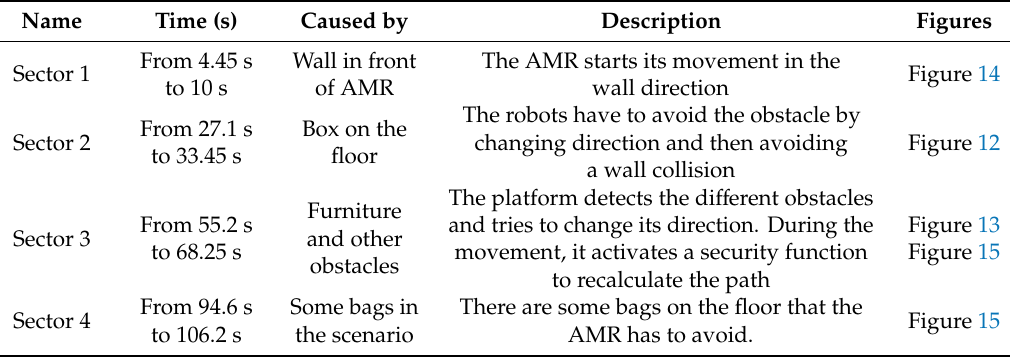
Table 2. Mobile Robot trajectory events.